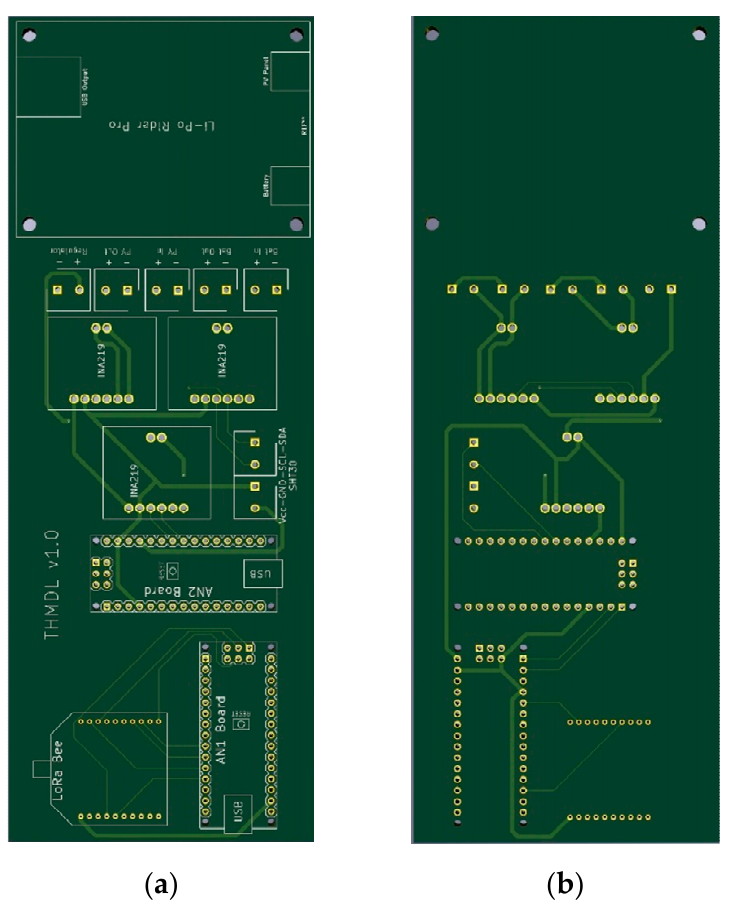
Figure 5. PCB of the THMDL with battery and solar panel power supply: ( a ) front side and ( b ) back side.